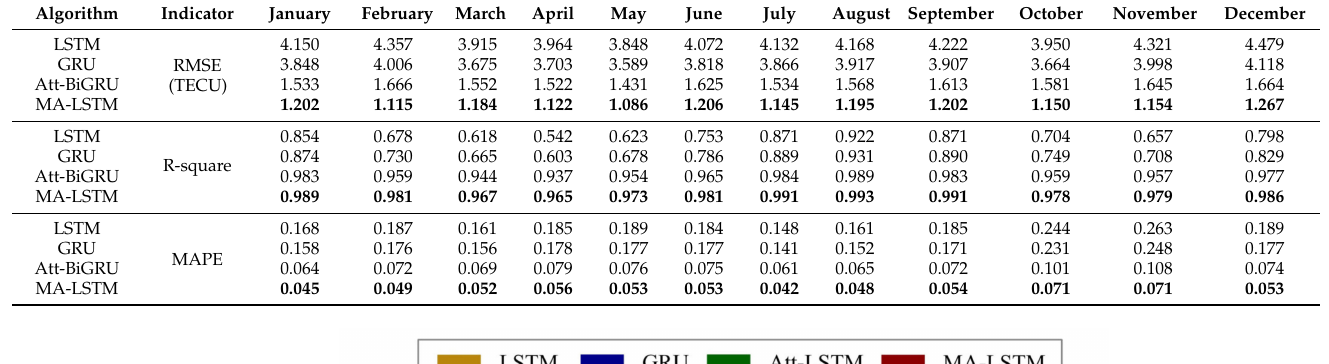
Table 4. Comparison of prediction performance by month.